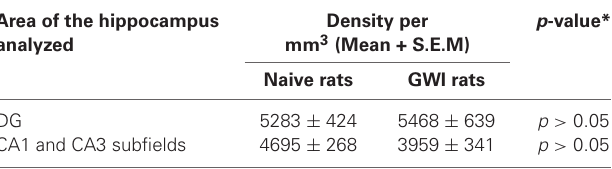
Table 2 | Density of neuropeptide Y (NPY) positive interneurons in the hippocampus . Area of the hippocampus Density per p -value* analyzed mm 3 (Mean + S.E.M) Naive rats GWI rats DG 5283 ± 424 5468 ± 639 p >